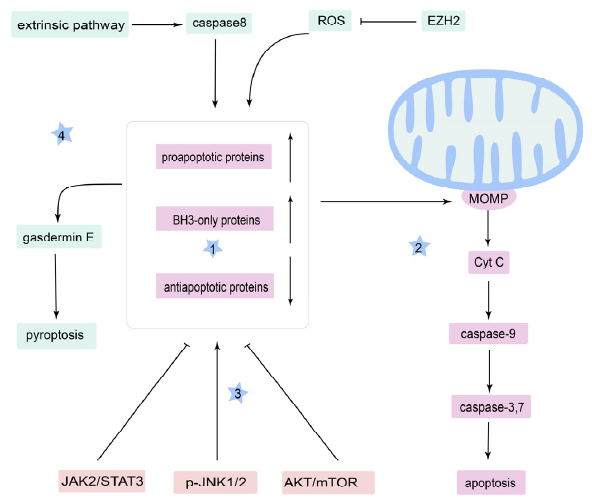
Figure 2. Mitochondrial apoptosis pathway in OSCC therapy. (1) Upregulation of the BH3-only proteins and the proapoptotic proteins, and reduced expression of the antiapoptotic proteins can cause (2) mitochondrial outer membrane permeabilization (MOMP) to promote the release of cytochrome C (Cyt C), which involves the activation of caspase-9 and in turn activates caspase-3 and caspase-7, leading to apoptosis. (3) Signaling pathways regulate the B-cell lymphoma 2 (Bcl-2) protein family to induce MOMP. (4) Other cell activities related to the mitochondrial apoptosis